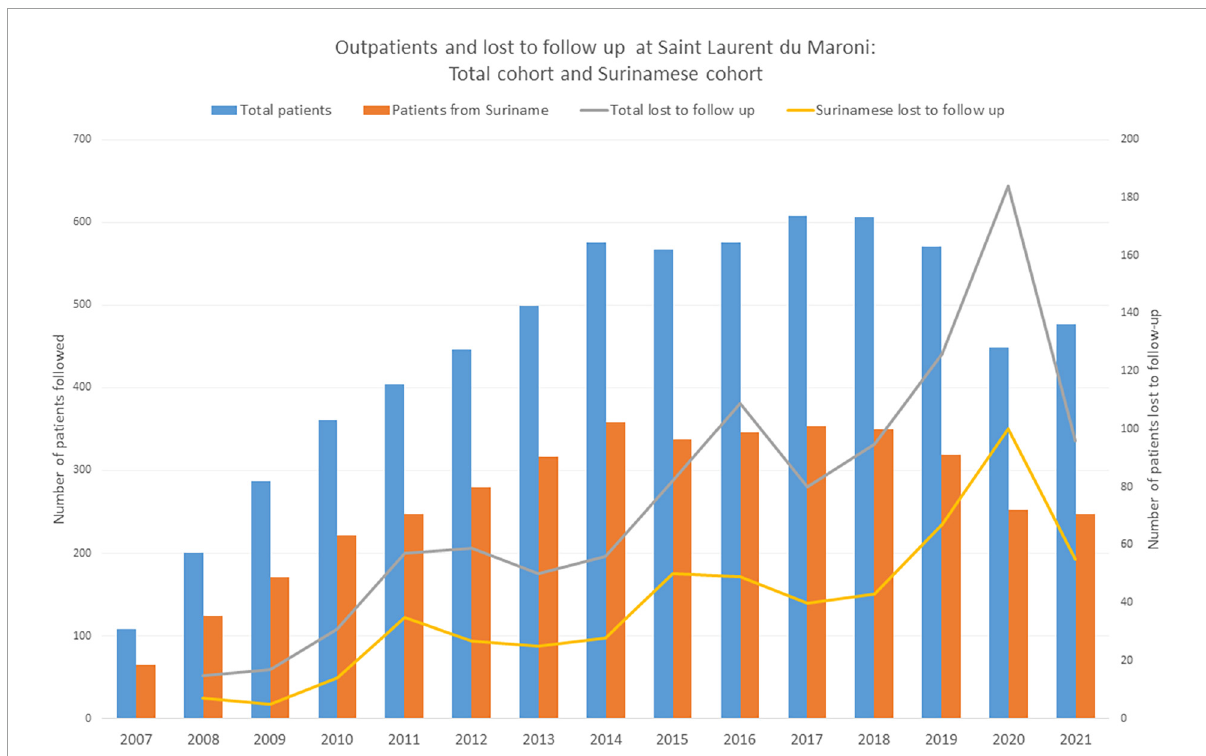
FIGURE3 Persons from Suriname represent the majority of patients from Saint Laurent du Maroni’s HIV outpatient clinic. A substantial proportion of all patients are lost to follow-up, notably patients from Suriname. In 2020 and 2021, following disruption of health services and border closure, the number of outpatients seen for HIV follow-up declined significantly due to the impact of the COVID-19